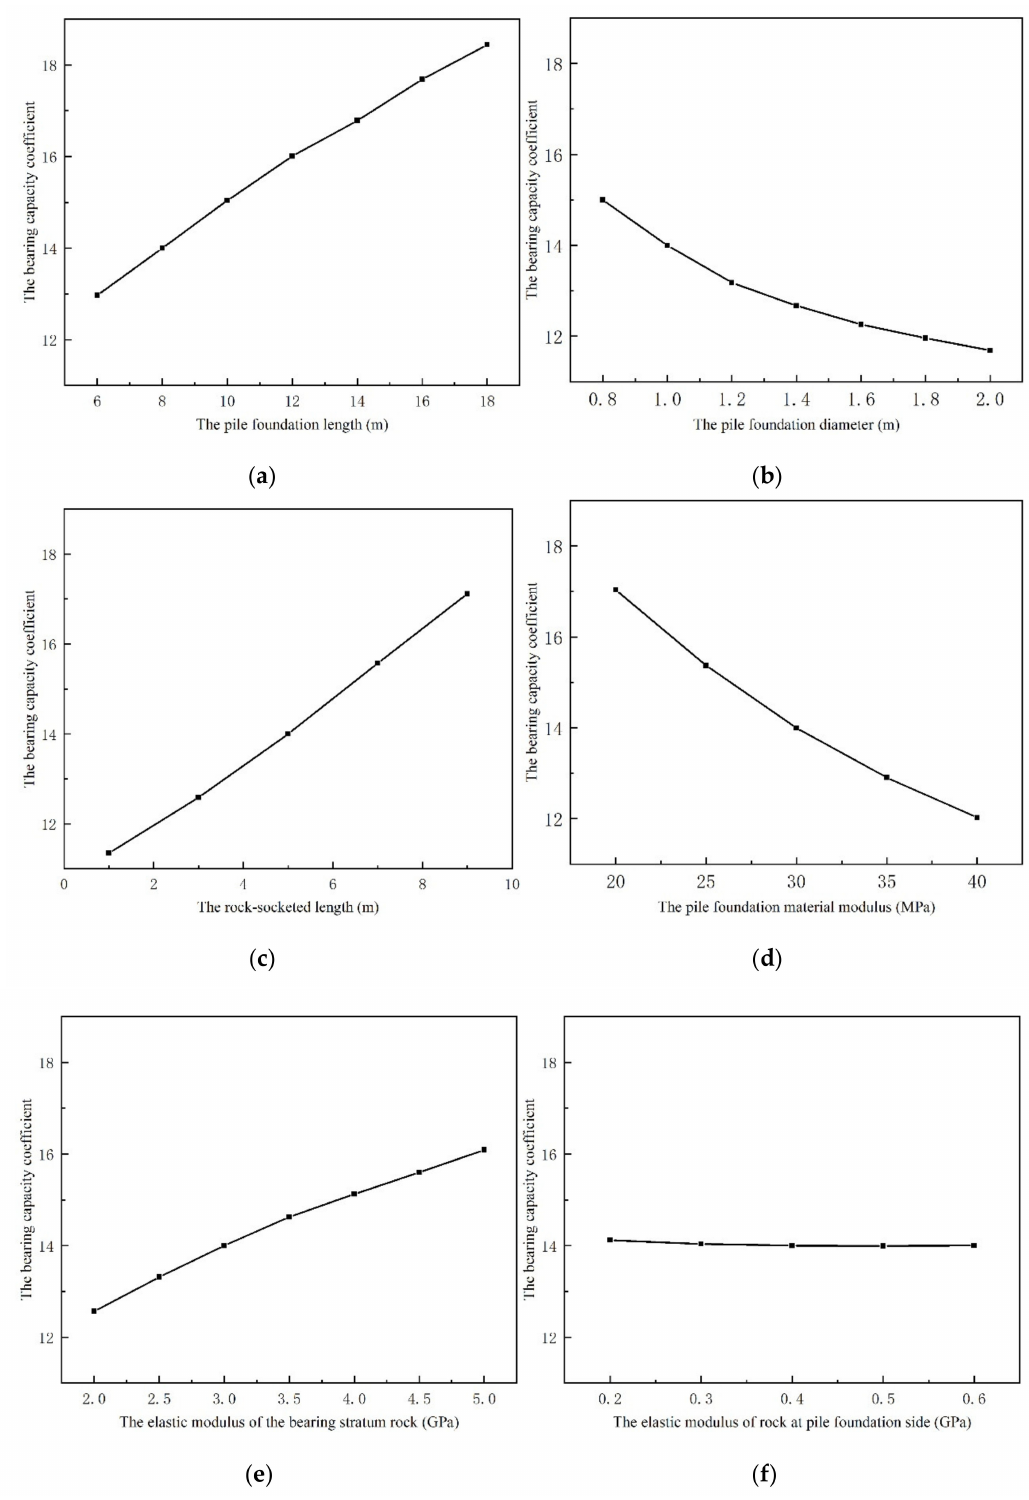
Figure 3. The bearing capacity coefficient curves with different parameters: ( a ) the pile foundation length, ( b ) the pile foundation diameter, ( c ) the rock-socketed length, ( d ) the pile foundation modulus, ( e ) the modulus of the bearing stratum rock, and ( d ) the modulus of rock at pile